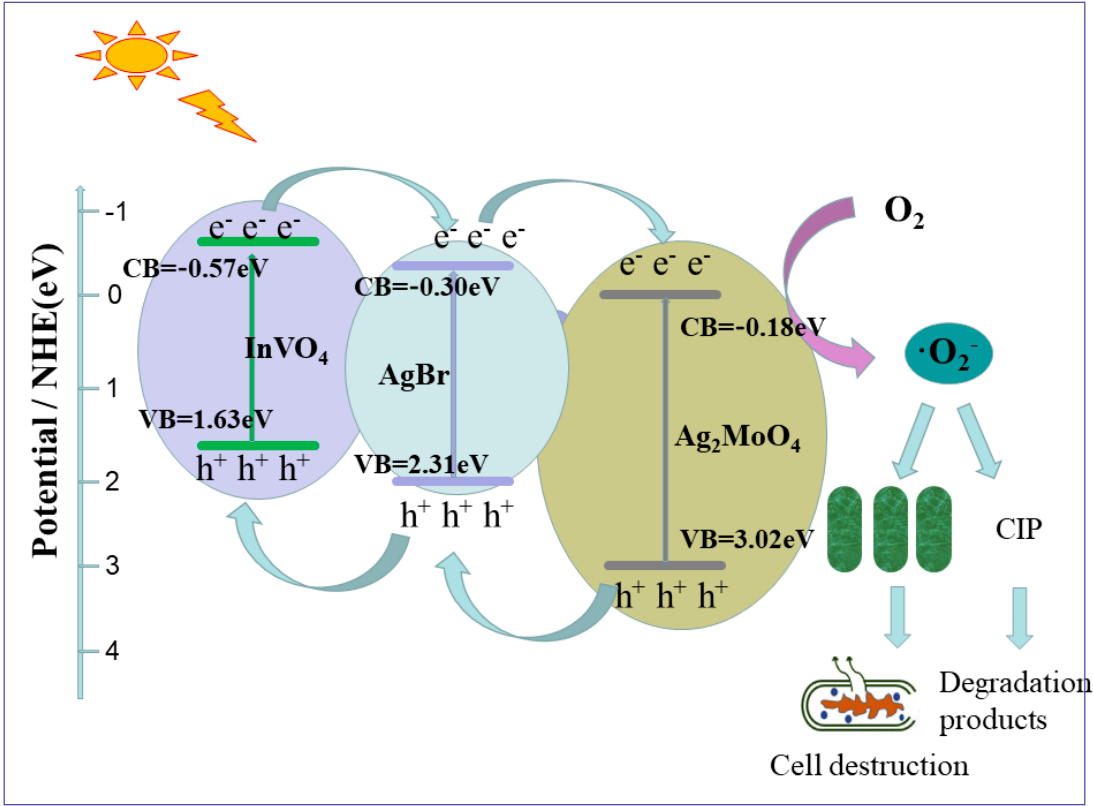
/ Ag 2 MoO 4 @InVO 4 photocatalytic